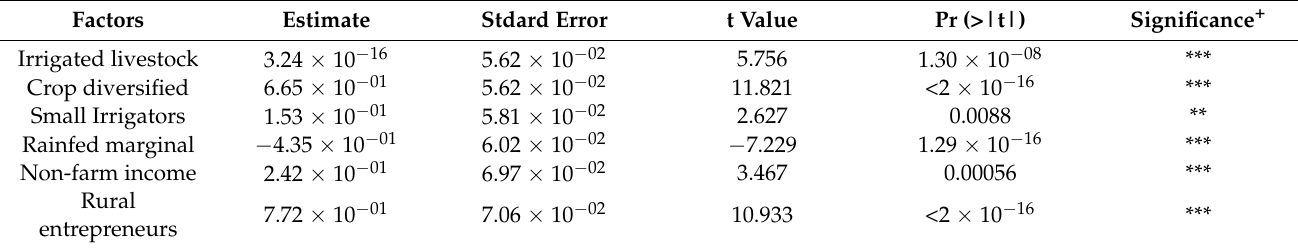
Table 6. Livelihood factors influencing farm household